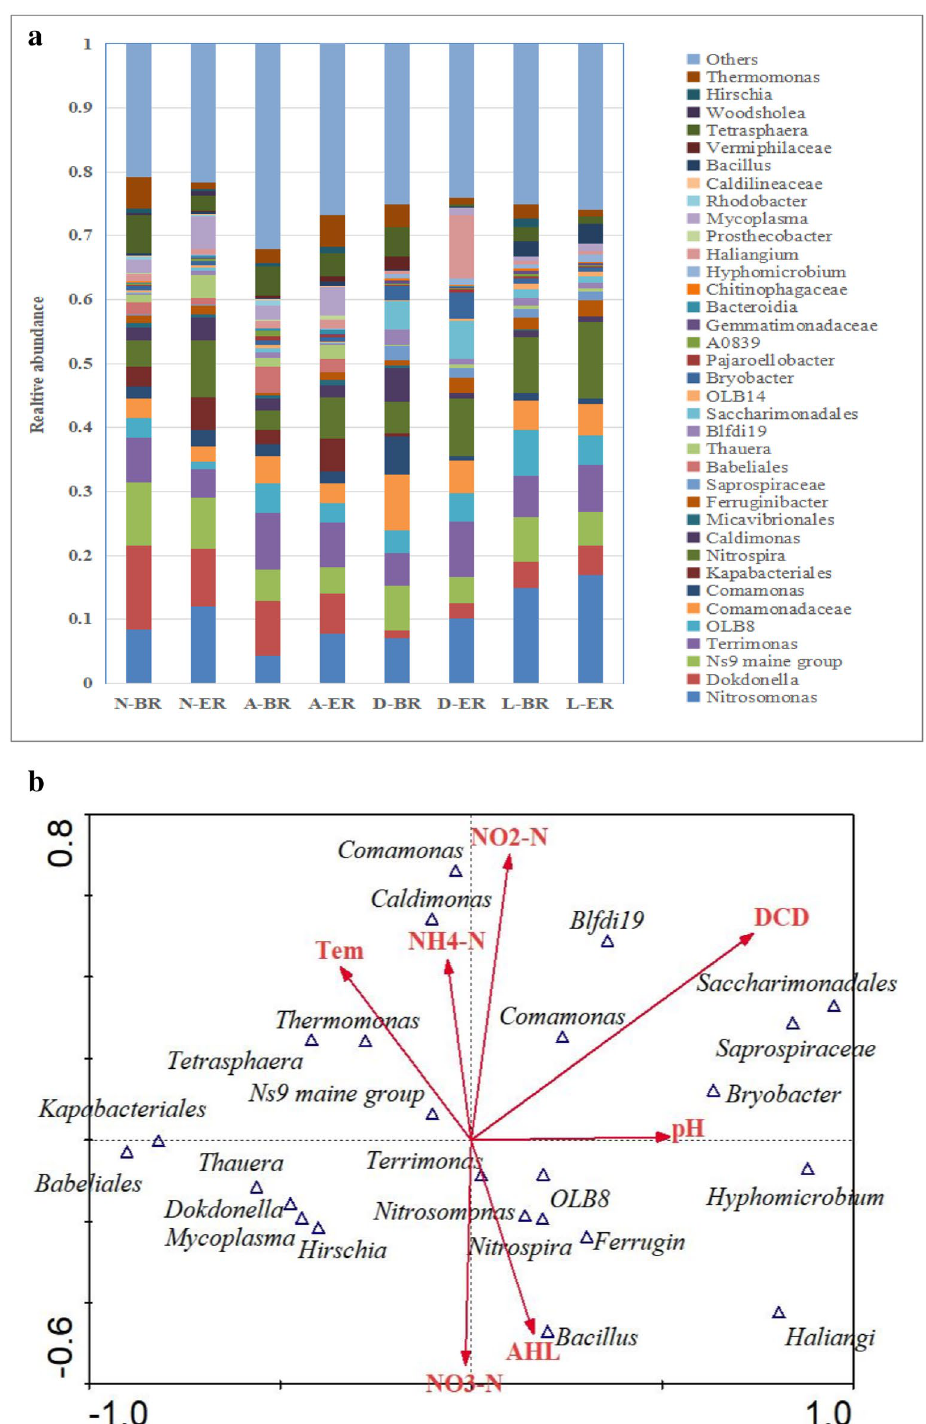
Figure 5. Bacterial compositions and canonical correspondence analysis between the environmental factors and community among 8 reactors. ( a ) distributions of bacterial community in the sludge in different reactors; ( b ) canonical correspondence analysis between the environmental factors and bacterial community. N normal group, A acid group, D DCD group, L low temperature group, BR blank reactor, ER experiment